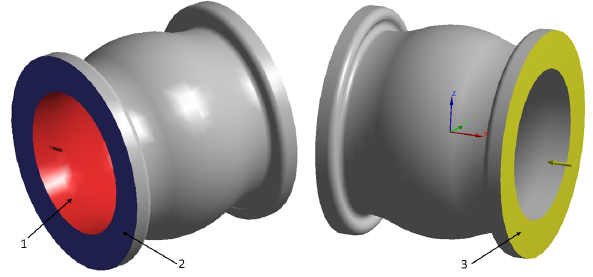
Figure 13: The deflection and von Misses stress distribution of the elastic diaphragm made of EPDM rubber. Load case: angular deflec- tion at 15 deg. and internal pressure 20 bar, a) generalized deflec-